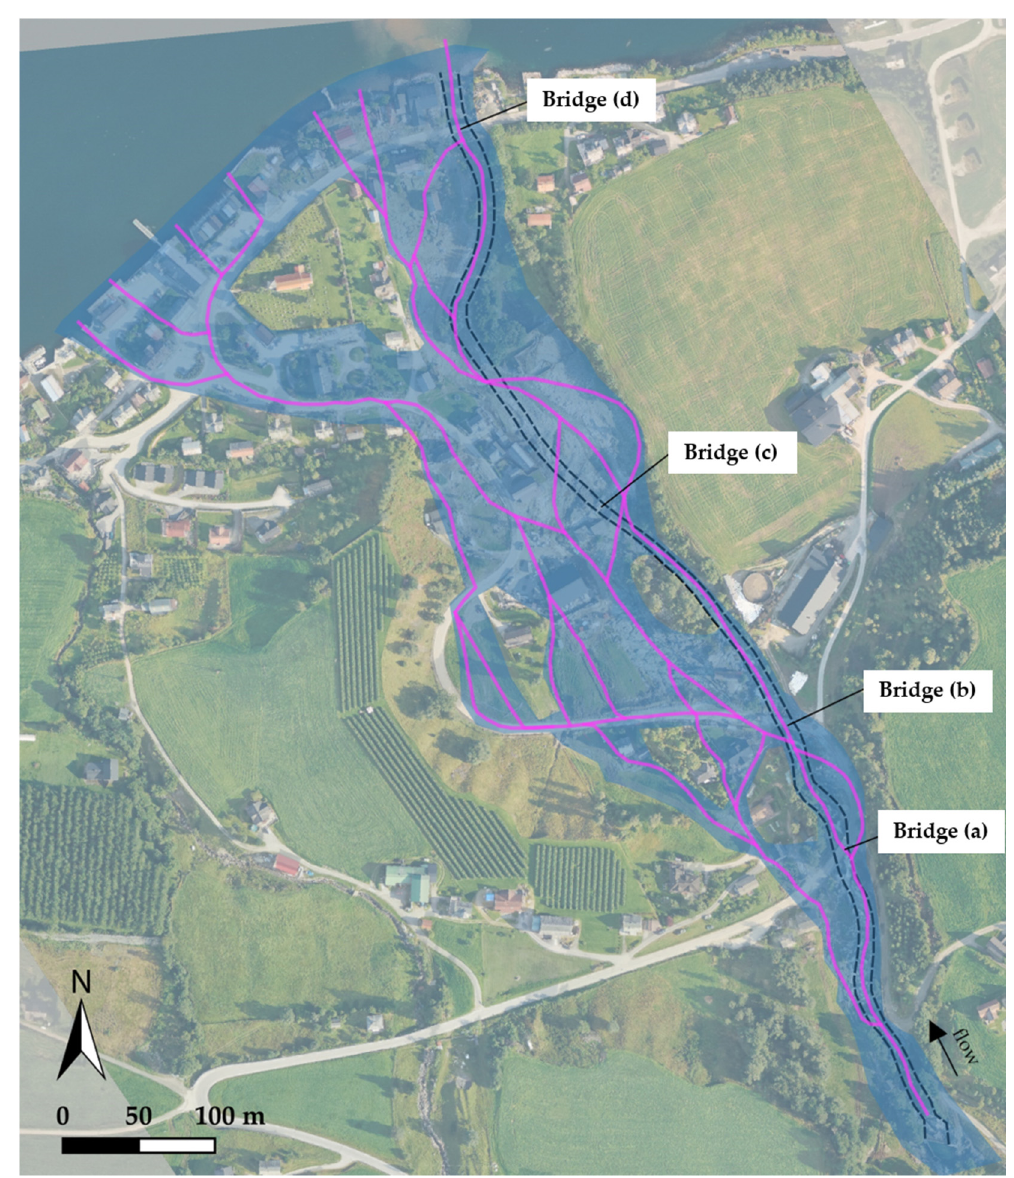
Figure 7. Maximum flooded area, i.e., wetted area in blue and dry areas as gaps in the blue area, throughout the 2017 flash flood. Bridges are labeled ( a – d ); flow paths (purple lines) as in Figure 6. Post-event orthophoto from [16].